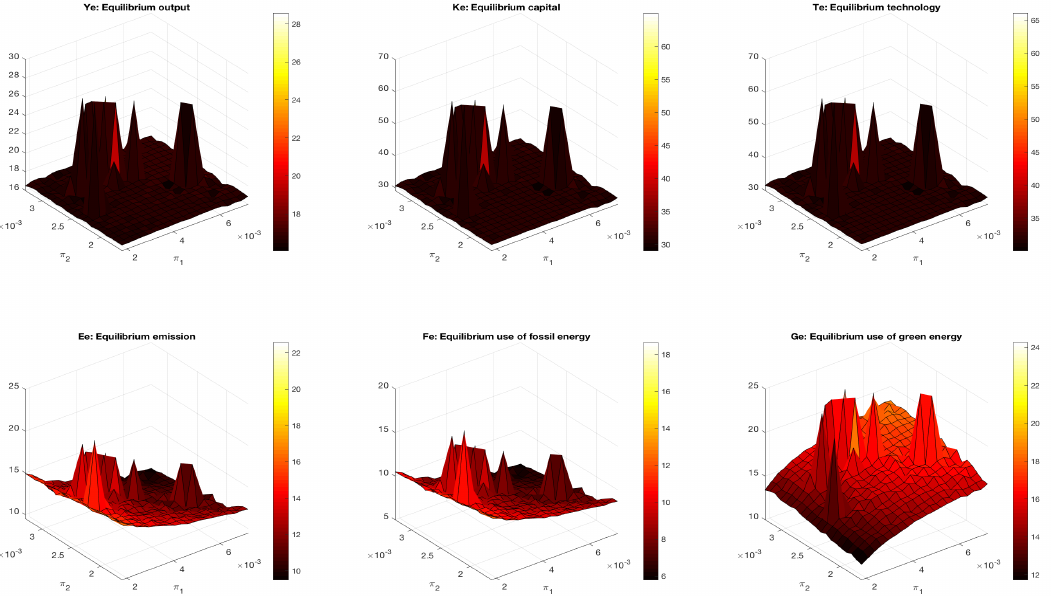
Figure A5. Equilibrium values OECD countries with different π i .